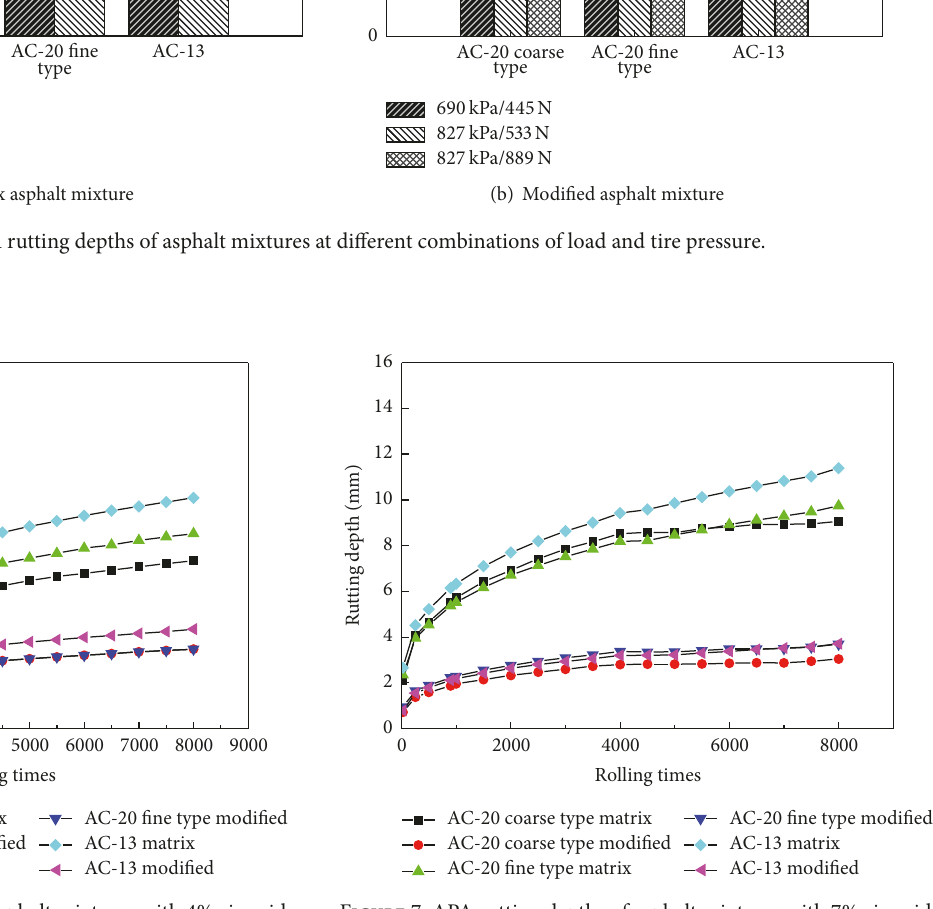
Figure 6: APA rutting depths of asphalt mixtures with 4% air voids at 60 ∘ C under immersing conditions.